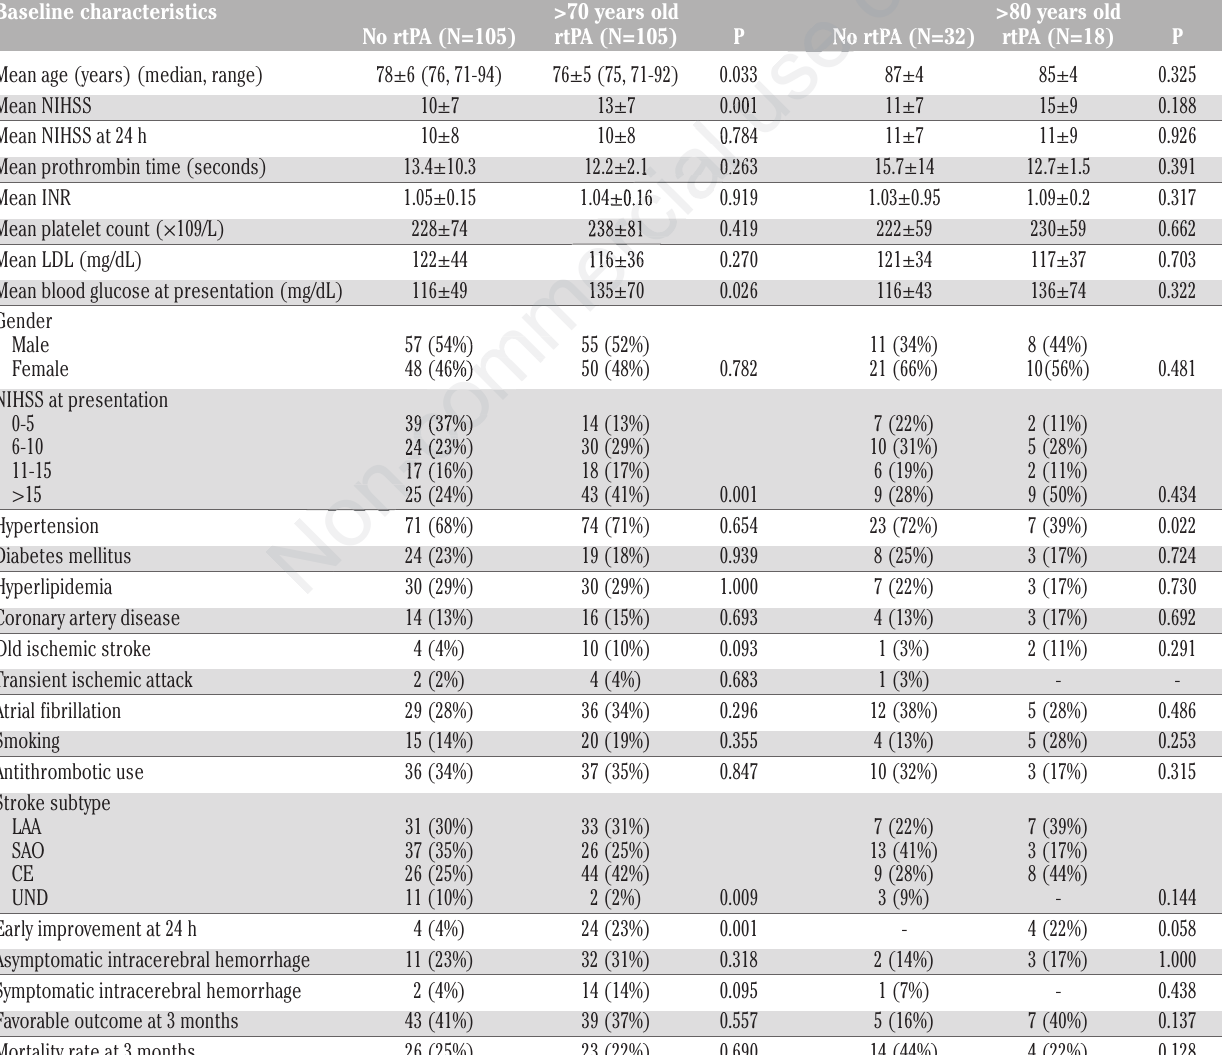
Table 1. Base-line characteristics and outcomes in aging patients (>70 years old) treated with and without intravenous recombinant-tis- sue plasminogen activator. Baseline characteristics Mean age (years) (median, range)